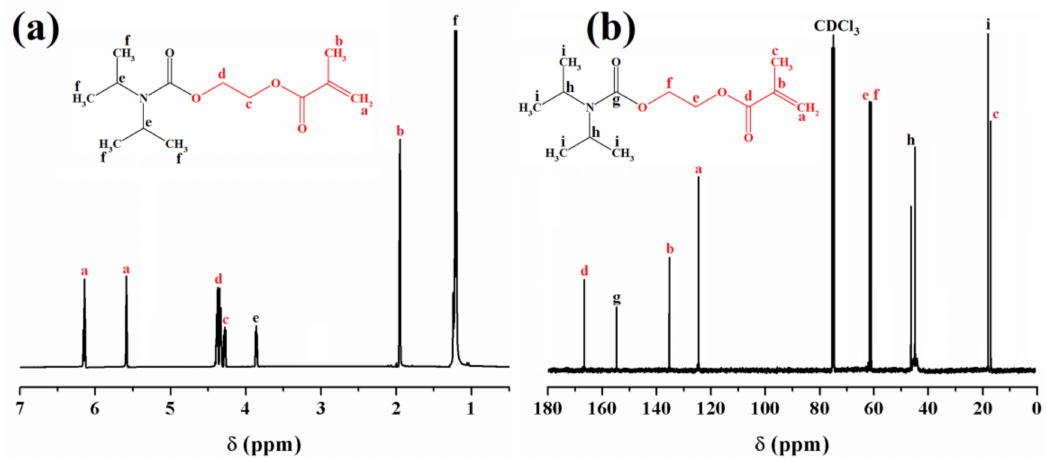
Figure 1. 1 H NMR ( a ) and 13 C NMR; ( b ) spectra of N,N-(diisopropylcarbamoyloxy)ethyl methacrylate (N-MA) in CDCl 3